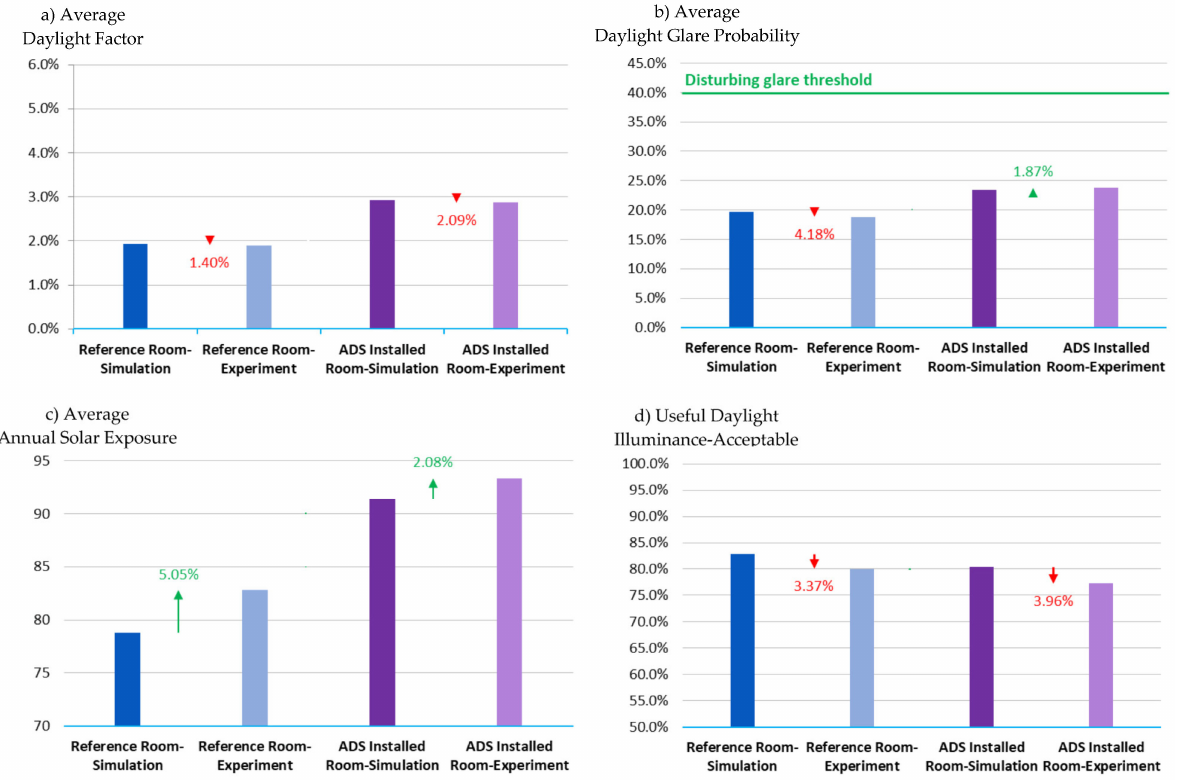
Figure 22. Daylight metrics experiments results compared with simulation for: ( a ) average DF; ( b ) average DGP; ( c ) average ASE. ( d ) The red and green figures show the